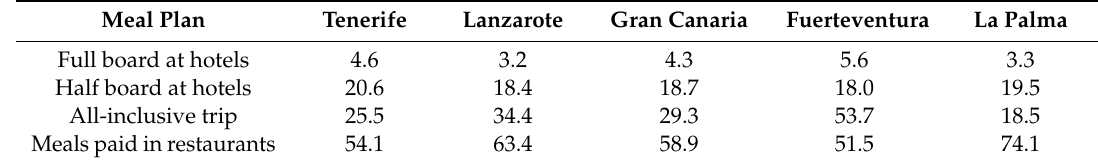
Table 2. Payment methods and places for tourists’ meals (%) during 2017. Meal